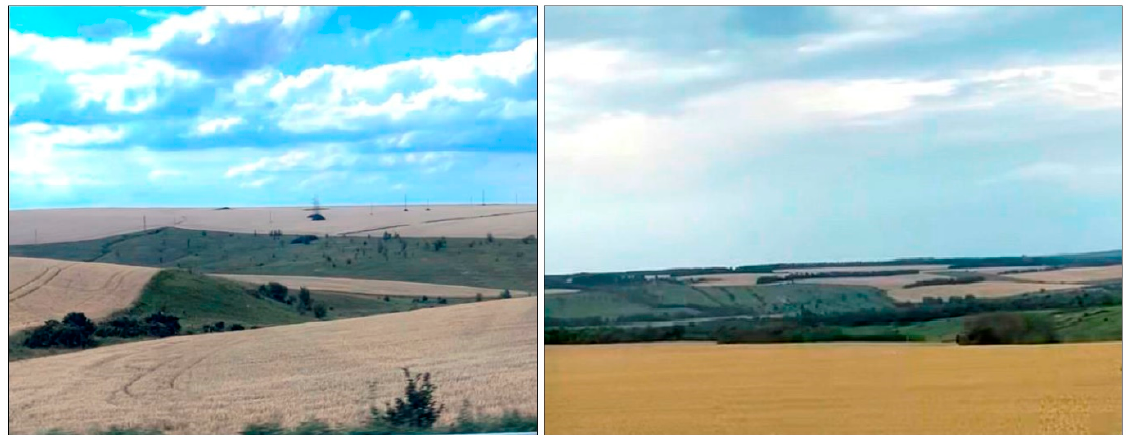
Figure 2. Cropland on the hilly slopes in Belgorod Oblast (Alekseyevsky district).